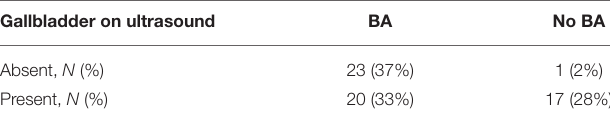
TABLE 2 | Sonographic comparison with diagnosis of biliary atresia. Gallbladder on